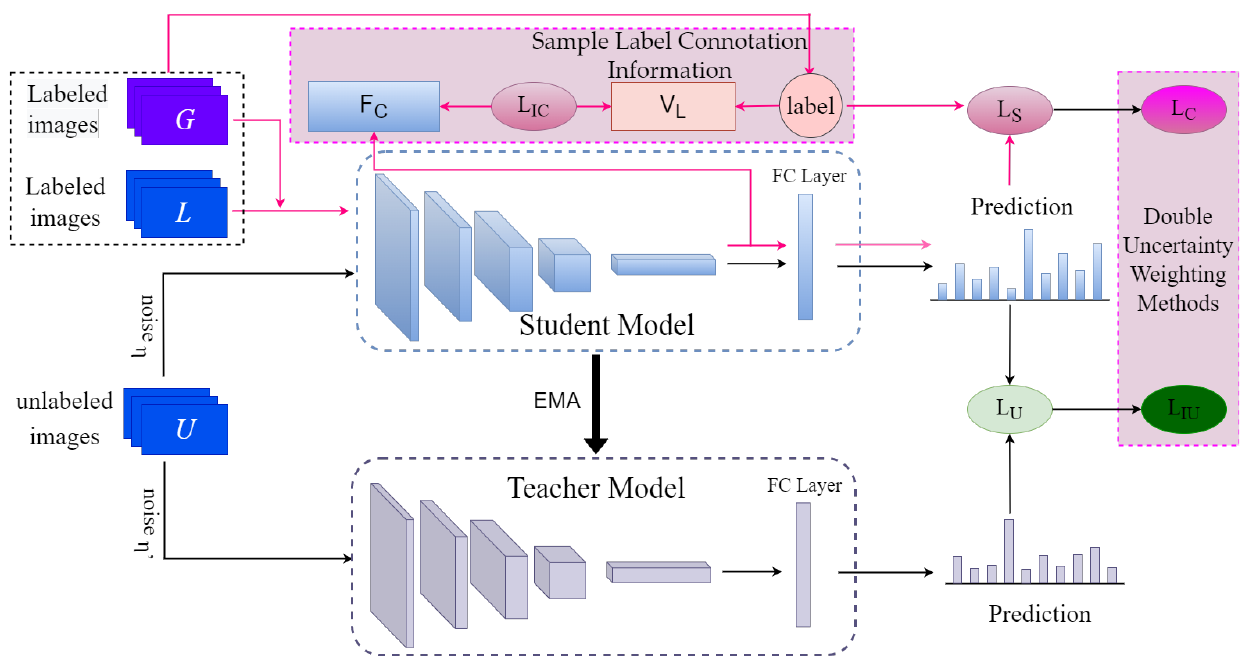
Figure 5. The general framework of the semi-supervised model.